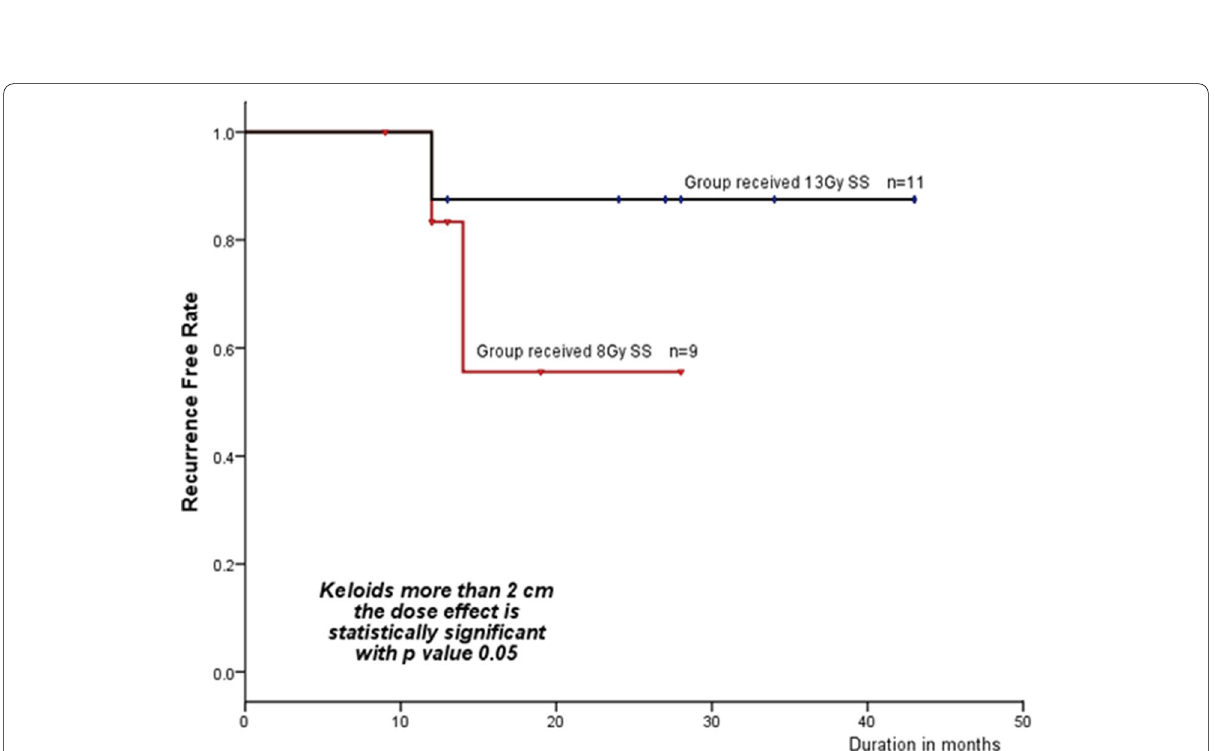
Fig. 5 The effect of increasing the dose on recurrence for keloids > 2 cm. The curve showed significant effect of increasing dose to 13 Gy/1fx compared to 8 Gy/1fx on the recurrence free survival for keloid cases with size more than 2